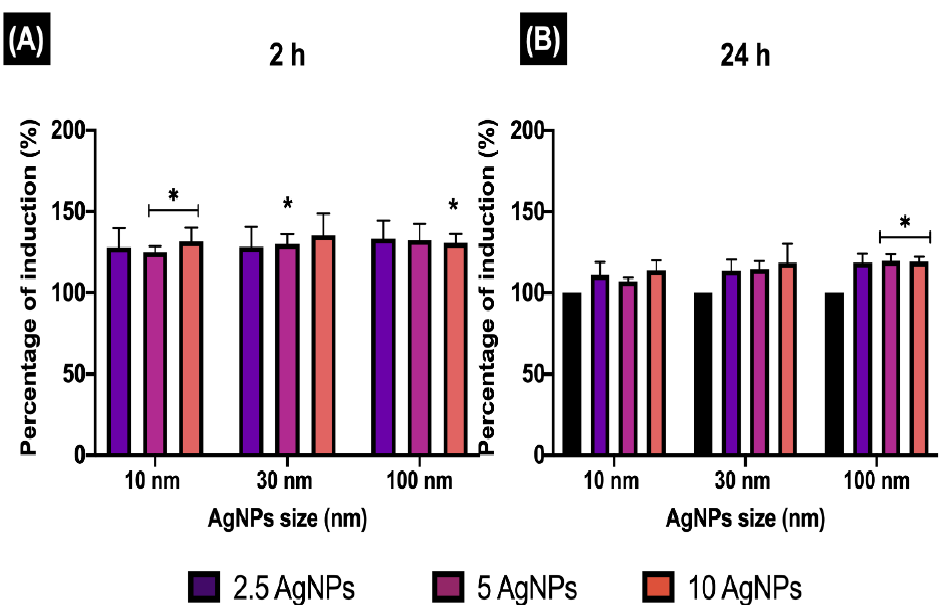
Figure 6. Early endosome induction. The percentage of EE induction (EEI) in ZF4 cells treated with 2.5, 5, and 10 µ g/mL of three different AgNP sizes (10, 30, and 100 nm) after ( A ) 2 and ( B ) 24 h. The intensity results were normalised to percentage (%) relative to the untreated cells (naive) (see Materials and Methods Section 2.6 for calculation). Data represent the mean of three individual replicates and above the bars the standard deviation (Mean ± SD). Data with asterisks (*) indicate a statistical difference (* p < 0.05) between the treatments compared to the untreated control (naive) at the specific timepoint.